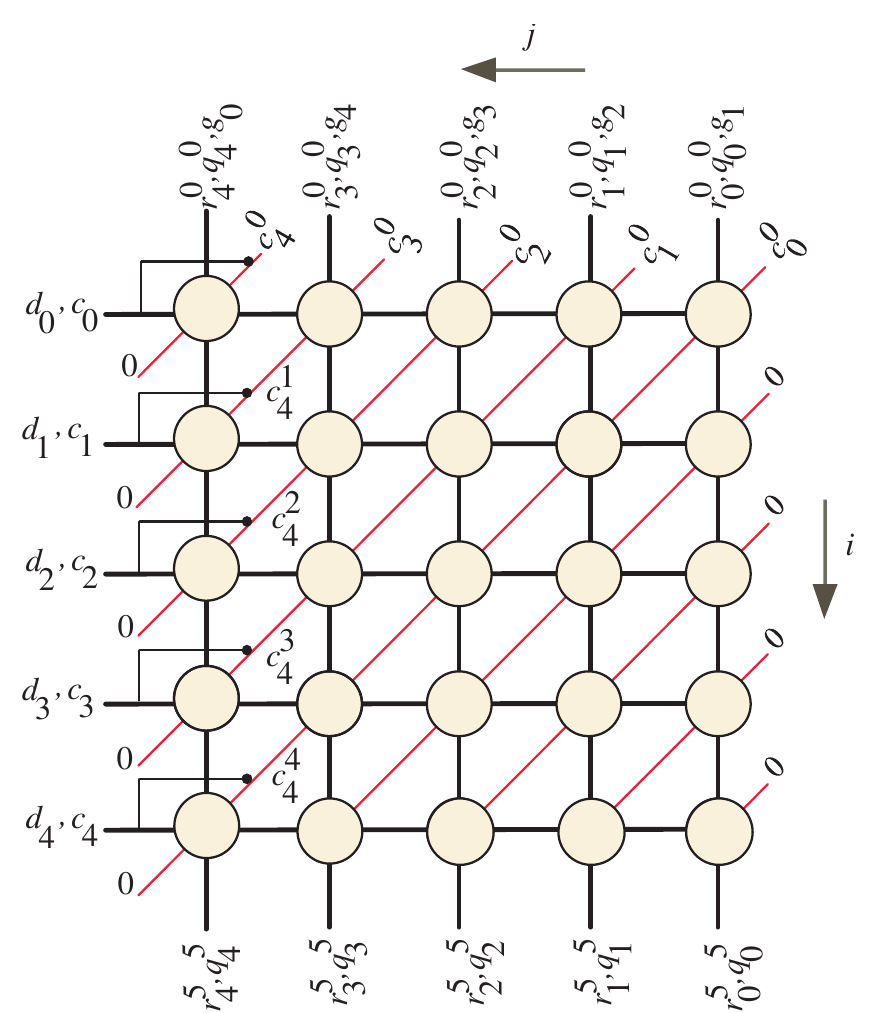
Figure 1. Dependence graph for the combined multiplication-squaring algorithm for m =